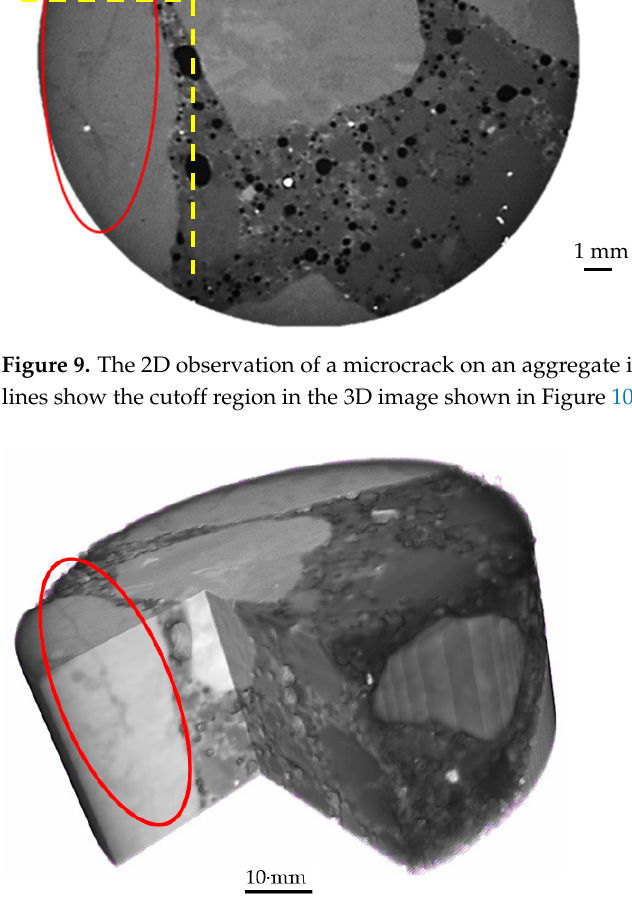
Figure 10. The 3D observation of a microcrack on the aggregate in one of the silane samples.